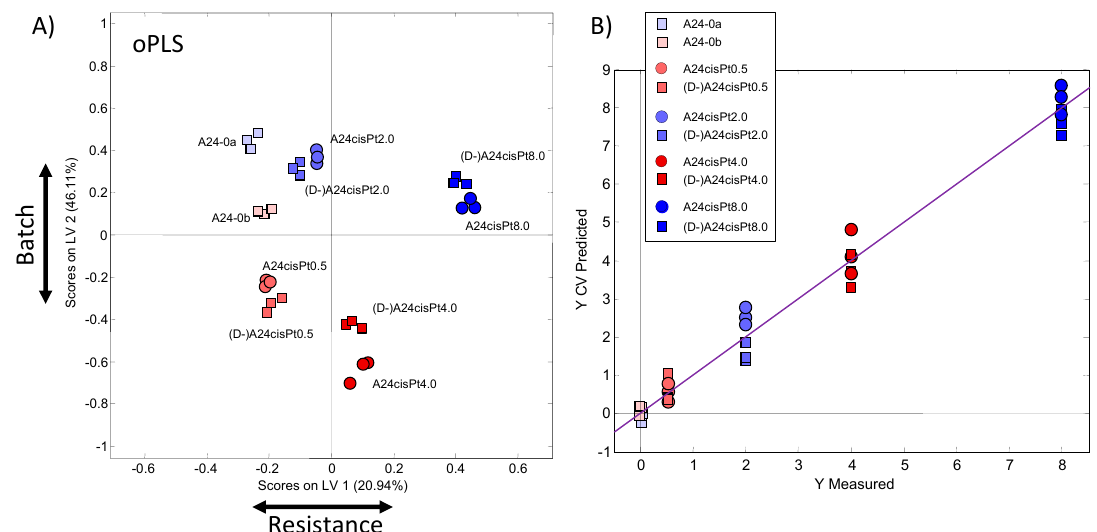
Figure 4. ( A ) oPLS scores plot (LV-1–LV-2) using the resistance as scaled prior knowledge (y-table). ( B ) Description of the PLS model showing the measured compared to the predicted resistance values.